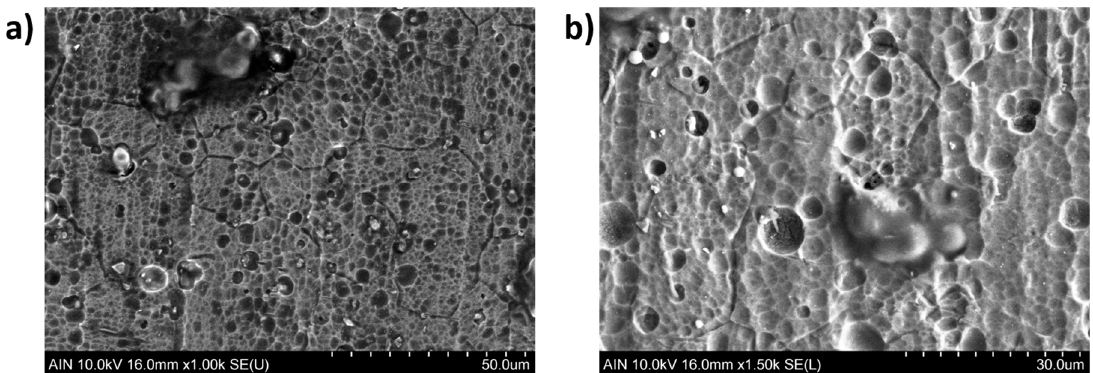
Figure 10. SEM images of the topographic surface of the sol-gel hybrid coatings for a scale bar of 50 μ m ( a ) and 30 μ m ( b ).